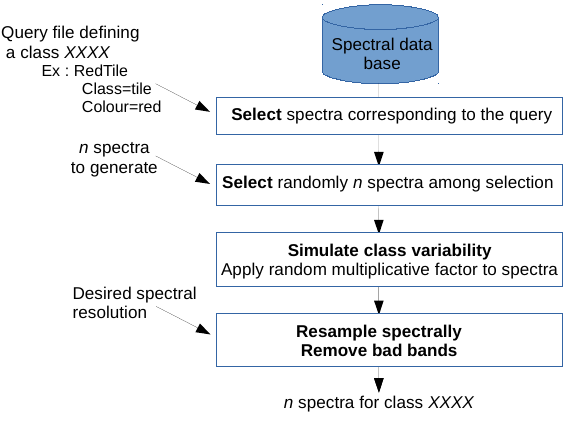
Figure 3: Synthetic spectra collection generation